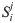
Example of the hierarchical structure of the world.This figure depicts an example of the hierarchical structure of the world which fulfills the locality in space assumption, and has a fixed number of hidden states. The hierarchy has two levels, in L0 there are 3 parallel Markov models, and one in L1 on the top. The Sij denotes state i in layer j. The numbers denoting the transition probabilities are just for illustrative purposes. Each green box represents densely connected part of the transition probability graph that should be represented as one node on a higher level. As a consequence, the transitions on L1 appear less frequently than on L0 (temporal abstraction) and span bigger spatial area (spatial abstraction).